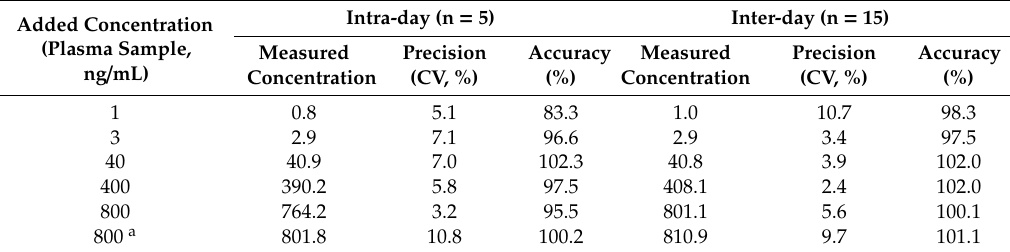
Table 1. Accuracy and precision of the assay for KD025 in rat